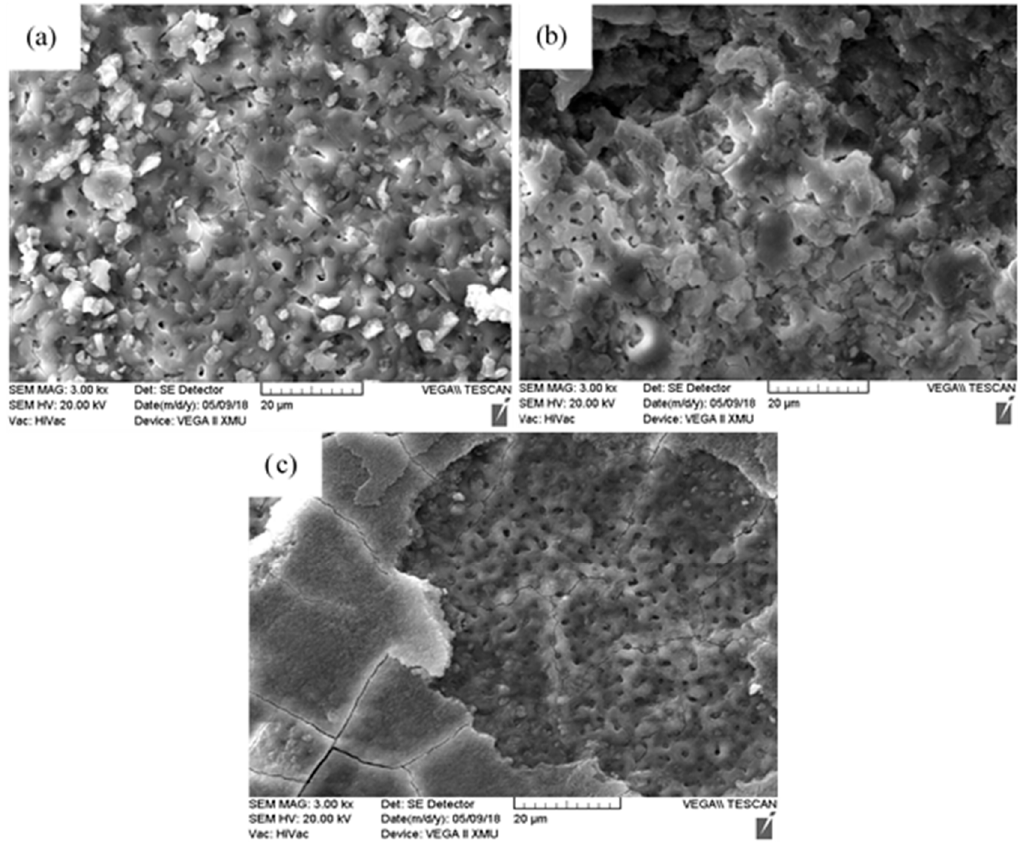
Figure 5. Macrograph of three MAO coatings, ( a ) MAO, ( b ) MAO–Cu 2 CO 3 (OH) 2 ·H 2 O and ( c ) MAO–